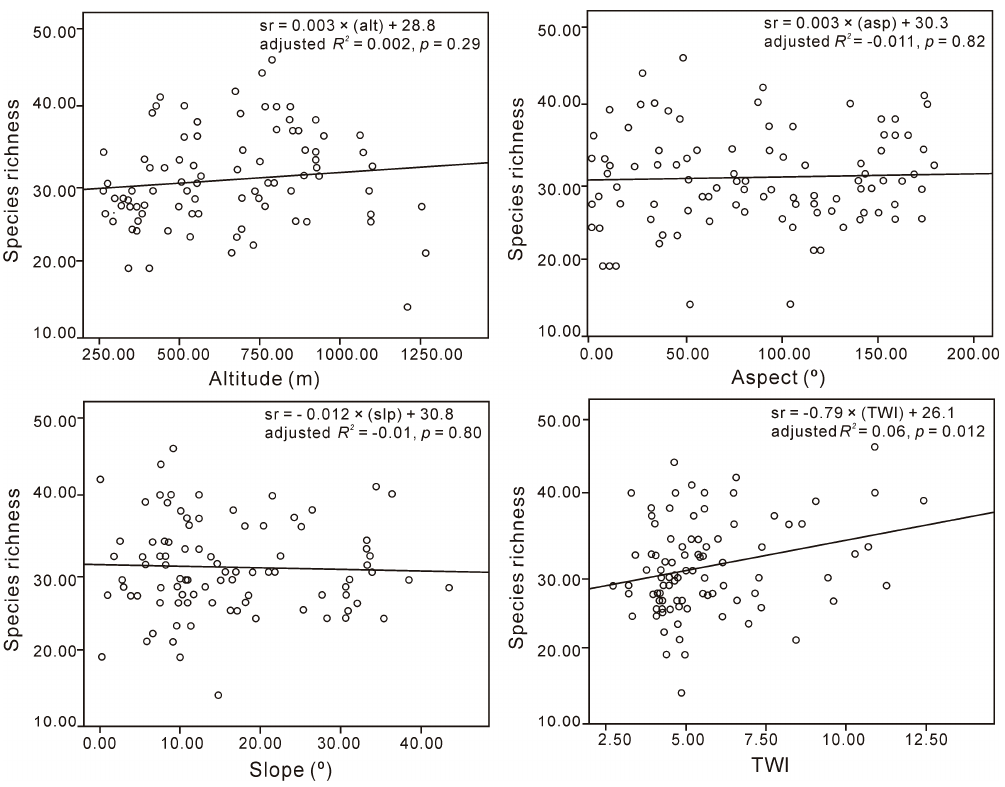
Figure 3. Estimated response lines of species richness (sr) to altitude (alt), aspect (asp), slope (slp) and the Topographical Wetness Index (TWI) based on the linear model.